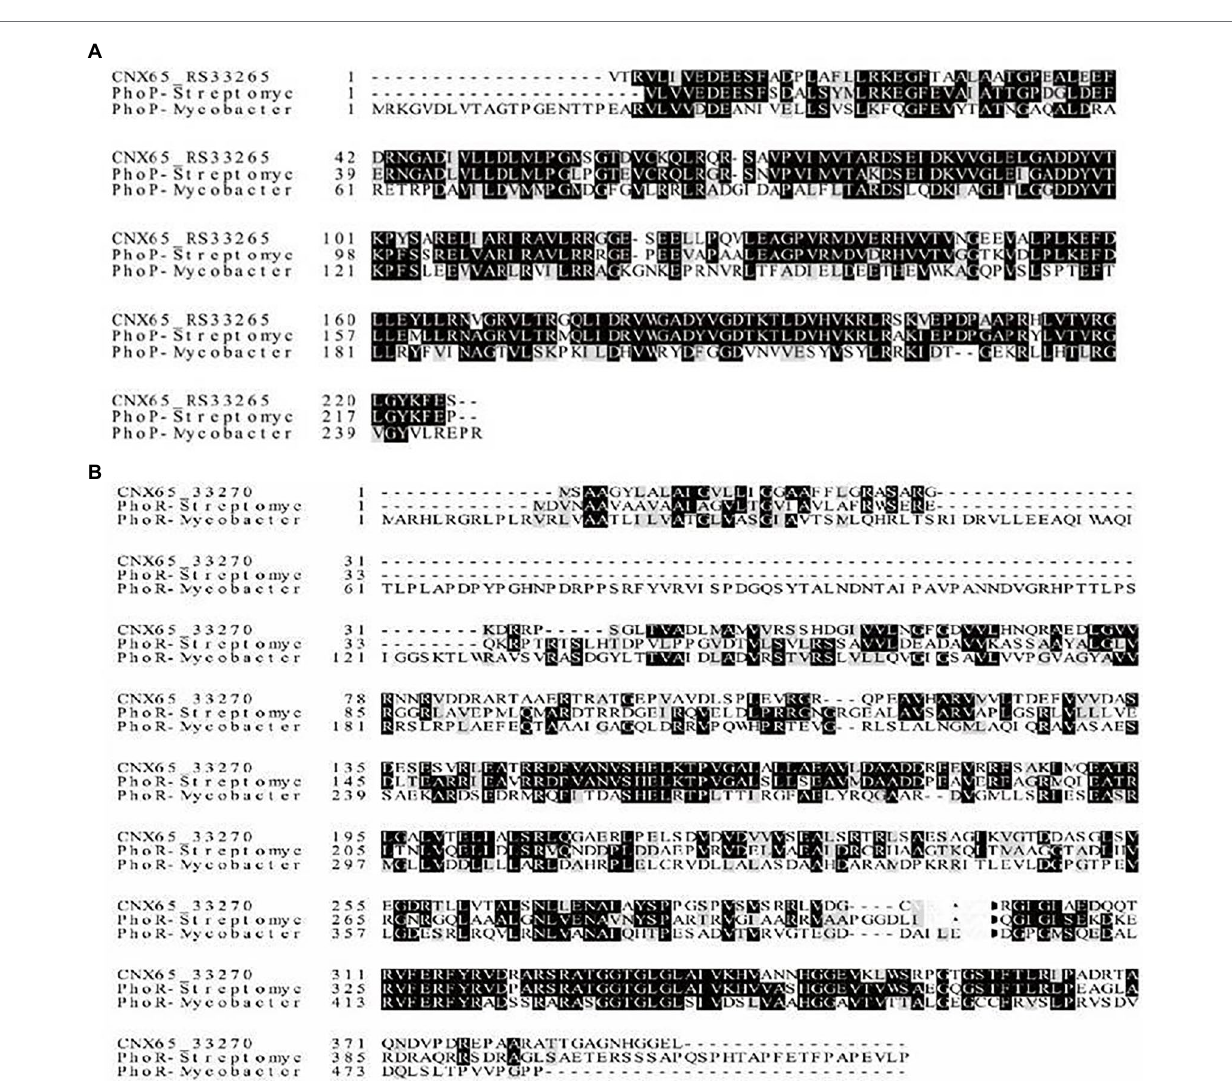
FIGURE 1 | Amino acid alignment of PhoP and PhoR in Actinosynnema pretiosum X47. Sequence comparison of PhoP (A) and PhoR (B) of A. pretiosum X47 and their counterparts in Streptomyces coelicolor A3(2) and Mycobacterium tuberculosis H37Rv. Identical amino acid residues are highlighted in black, and similar residues are shown in